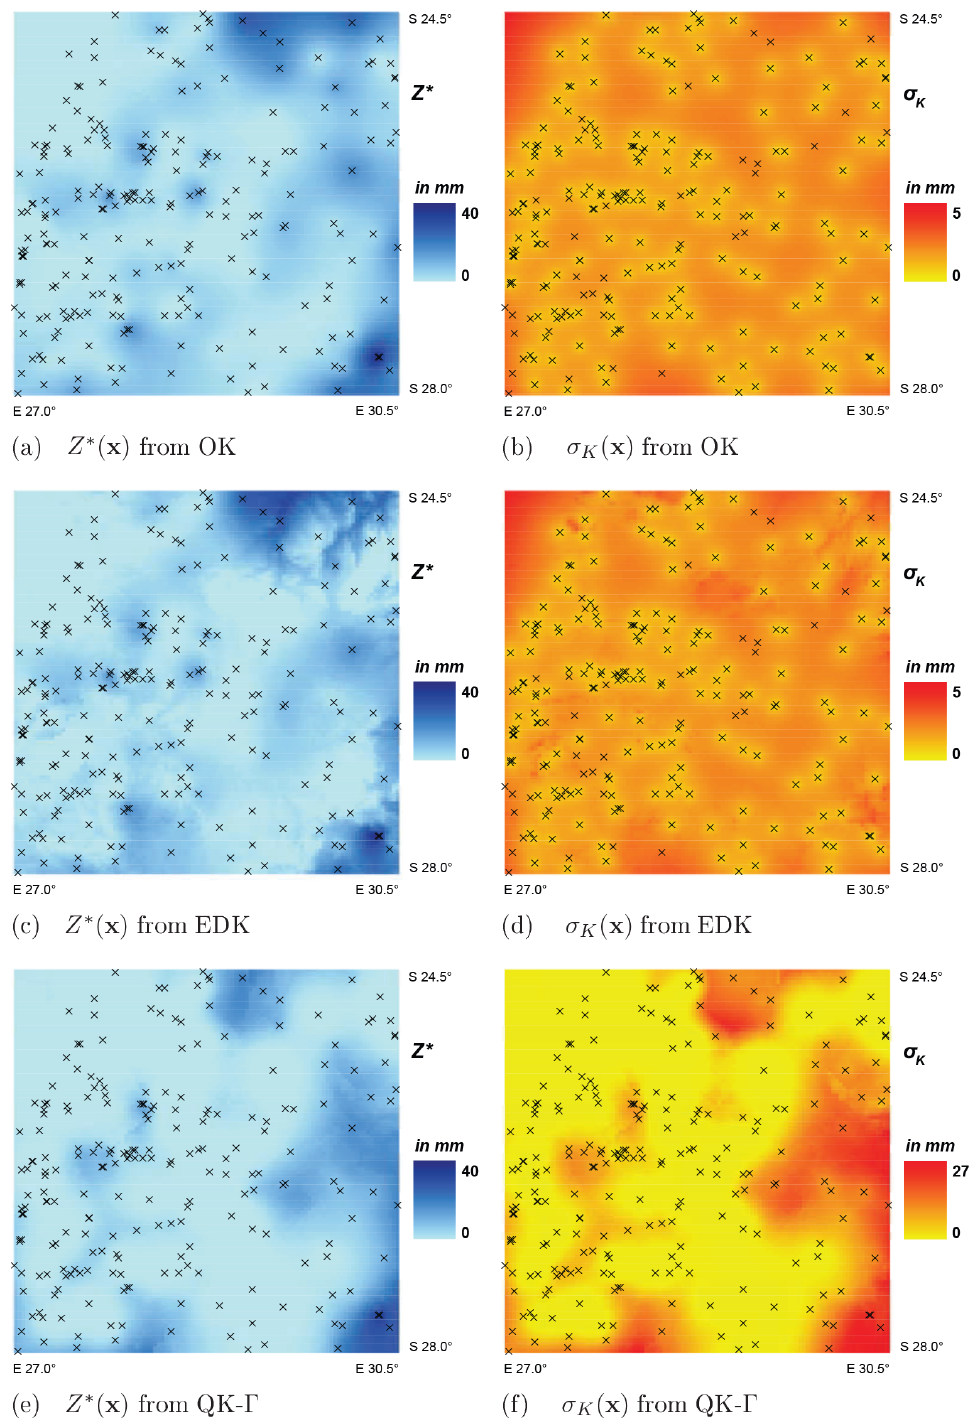
Figure 6. Spatial patterns of the estimator Z ∗ ( x ) and the standard deviation σ K ( x ) from OK, EDK and QK- (cid:48) for August 1993. Note that crosses indicate positions of